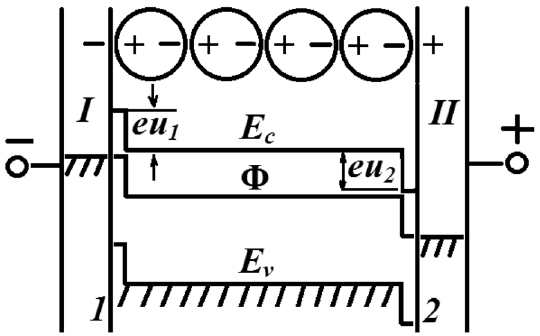
Figure 1. Energy-level diagram of the metal-powder-metal system included to an electrical circuit with a direct current. The powder is conventionally shown as a chain of polarized particles. E c is the bottom of the semiconductor conduction band; Φ is the Fermi level; u 1 and u 2 are contact differences of potentials between the polarized powder and electrodes I and II